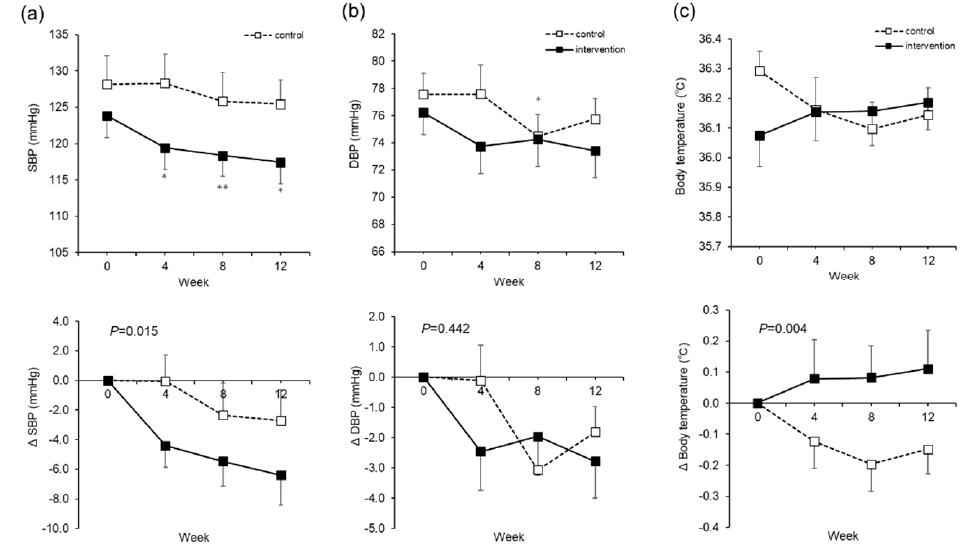
Figure 5. Systolic blood pressure (SBP), diastolic blood pressure (DBP), and body temperature. The actual level (upper) and changes (lower) in SBP ( a ). The actual level (upper) and changes (lower) in DBP ( b ). Body temperature. The actual level (upper) and changes (lower) in body temperature. The dotted line is the control group ( c ). The dotted line is the control group. The solid line is the intervention group. Mean ± SEM. The P value is the di ff erence between the groups for the change from Week 0 to Week 12. Two-way analysis of variance was performed. * Paired t -test adjusted by the Bonferroni method was performed for intragroup comparisons from Week 0. * p < 0.05, ** p < 0.001. In terms of renal function, in the intervention group, BUN decreased from 15.6 ± 4.4 to 13.8 ± 4.4 mg/dL from Week 0 to Week 8 ( p < 0.001) (Figure 6a). In the control group, eGFR decreased significantly from 66.6 ± 7.9 to 64.5 ± 7.2 mL/min/1.73 m 2 from Week 0 through Weeks 4 and 8 to Week 12 ( p = 0.003). In the intervention group, on the other hand, there was no significant change in eGFR (Figure 6b). Figure 6. Renal functions, plasma osmotic pressure, and urine aquaporin2/creatinine (AQP2/CRE). The actual level (upper) and changes (lower) in blood urea nitrogen (BUN) ( a ). The actual level (upper) and changes (lower) in the estimated glomerular filtration rate (eGFR) ( b ). The actual level